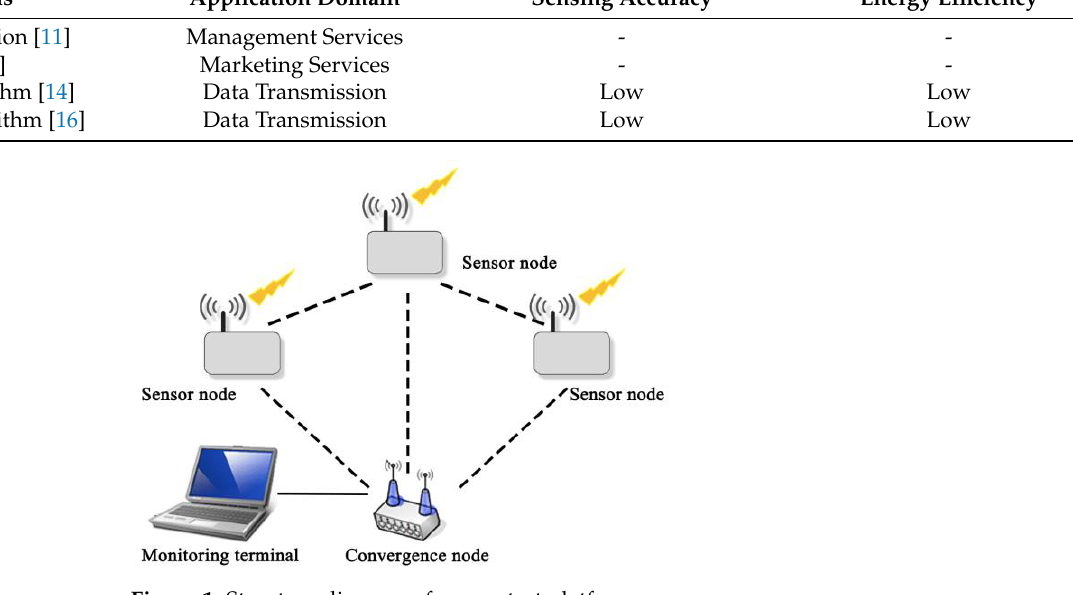
Figure 1. Structure diagram of sensor test platform.